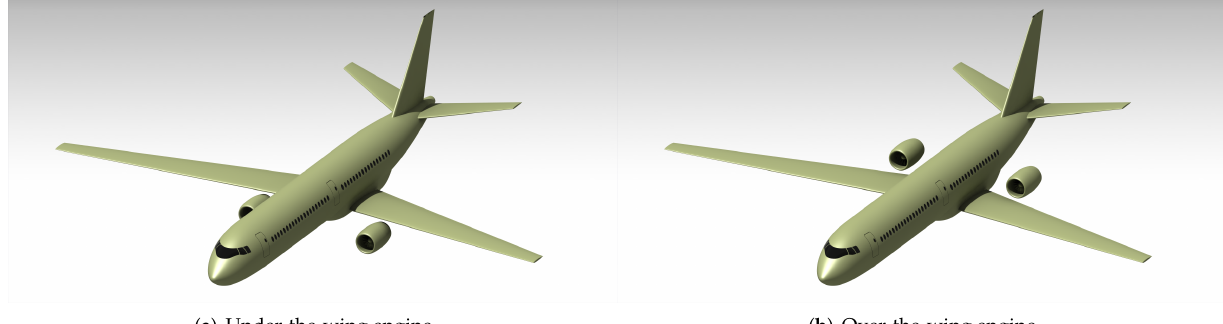
Figure 13. The two engine configurations considered for the trade